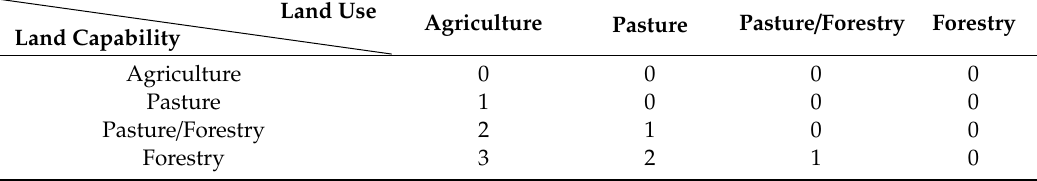
Table A1. Classification of land use conflict class according to land use and capability. Land